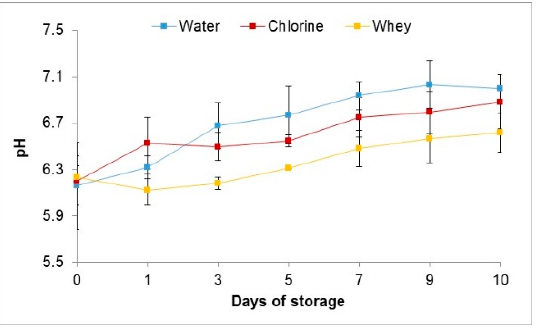
Figure 3. The pH measurements of the lettuce after sanitizer treatments, over 10 days in cold storage. Results represent the average of at least three replicate experiments (n = 3) ± SD.